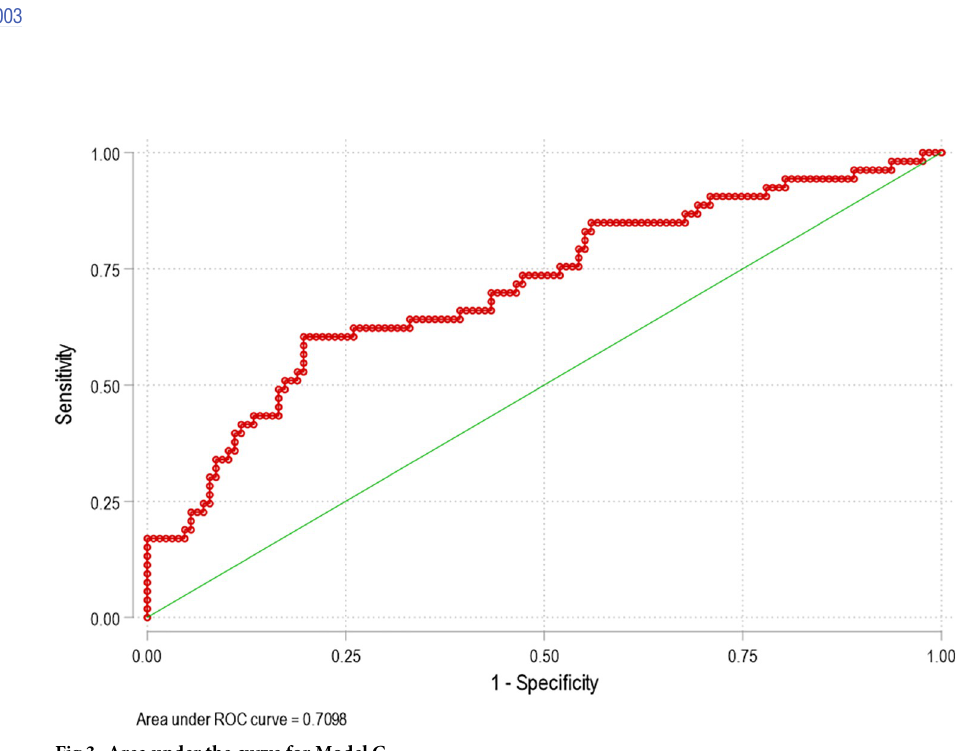
Fig 3. Area under the curve for Model